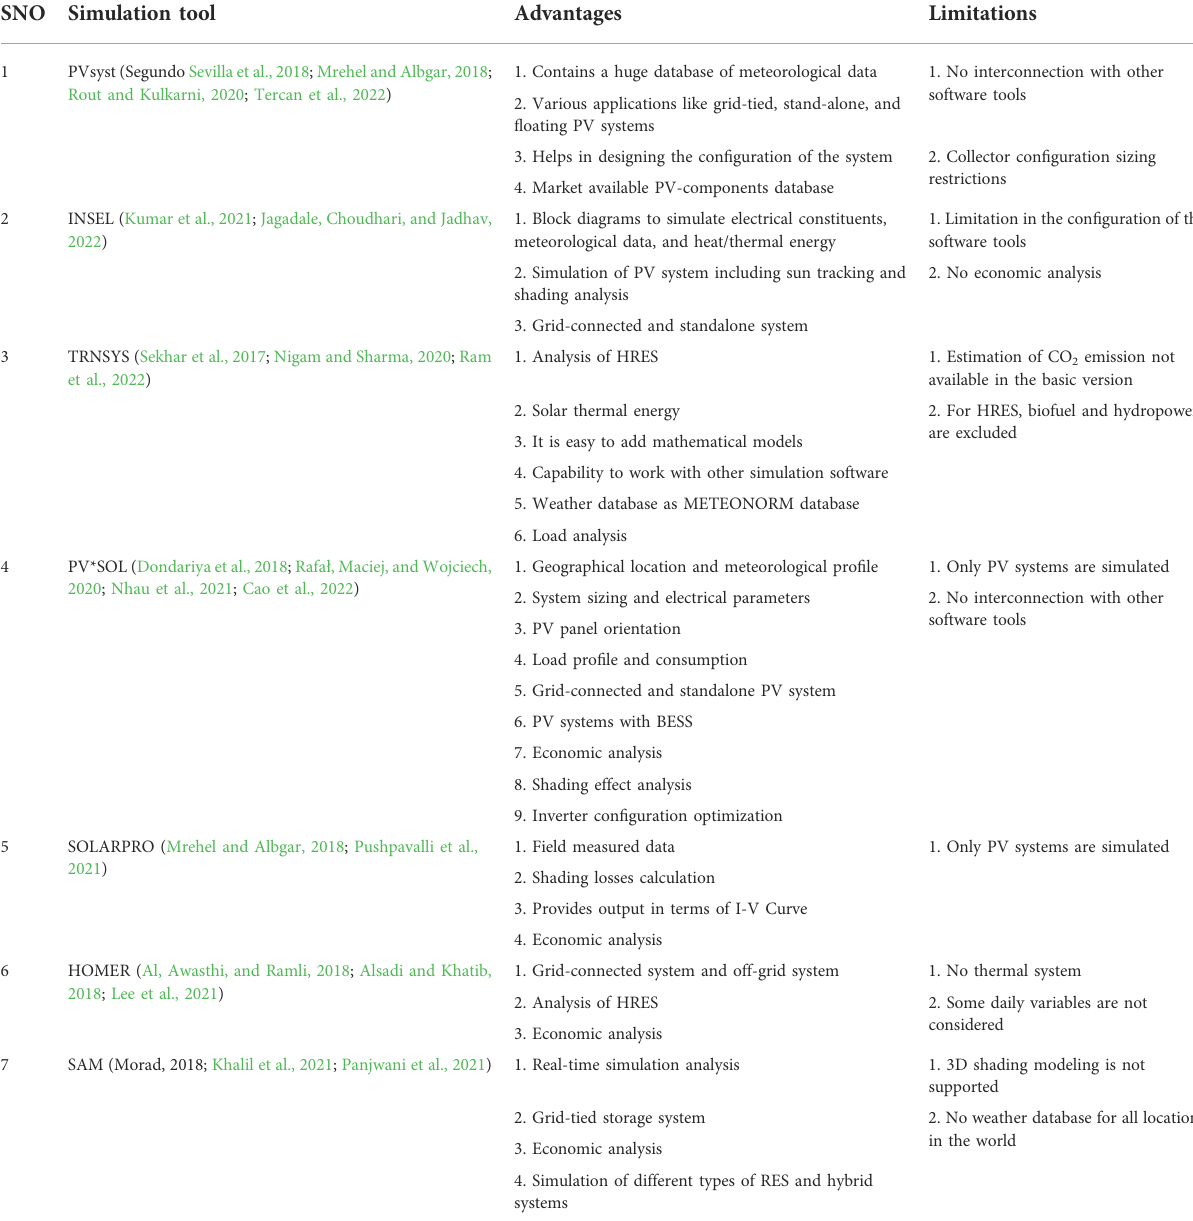
TABLE 1 Comparison of PV system simulation